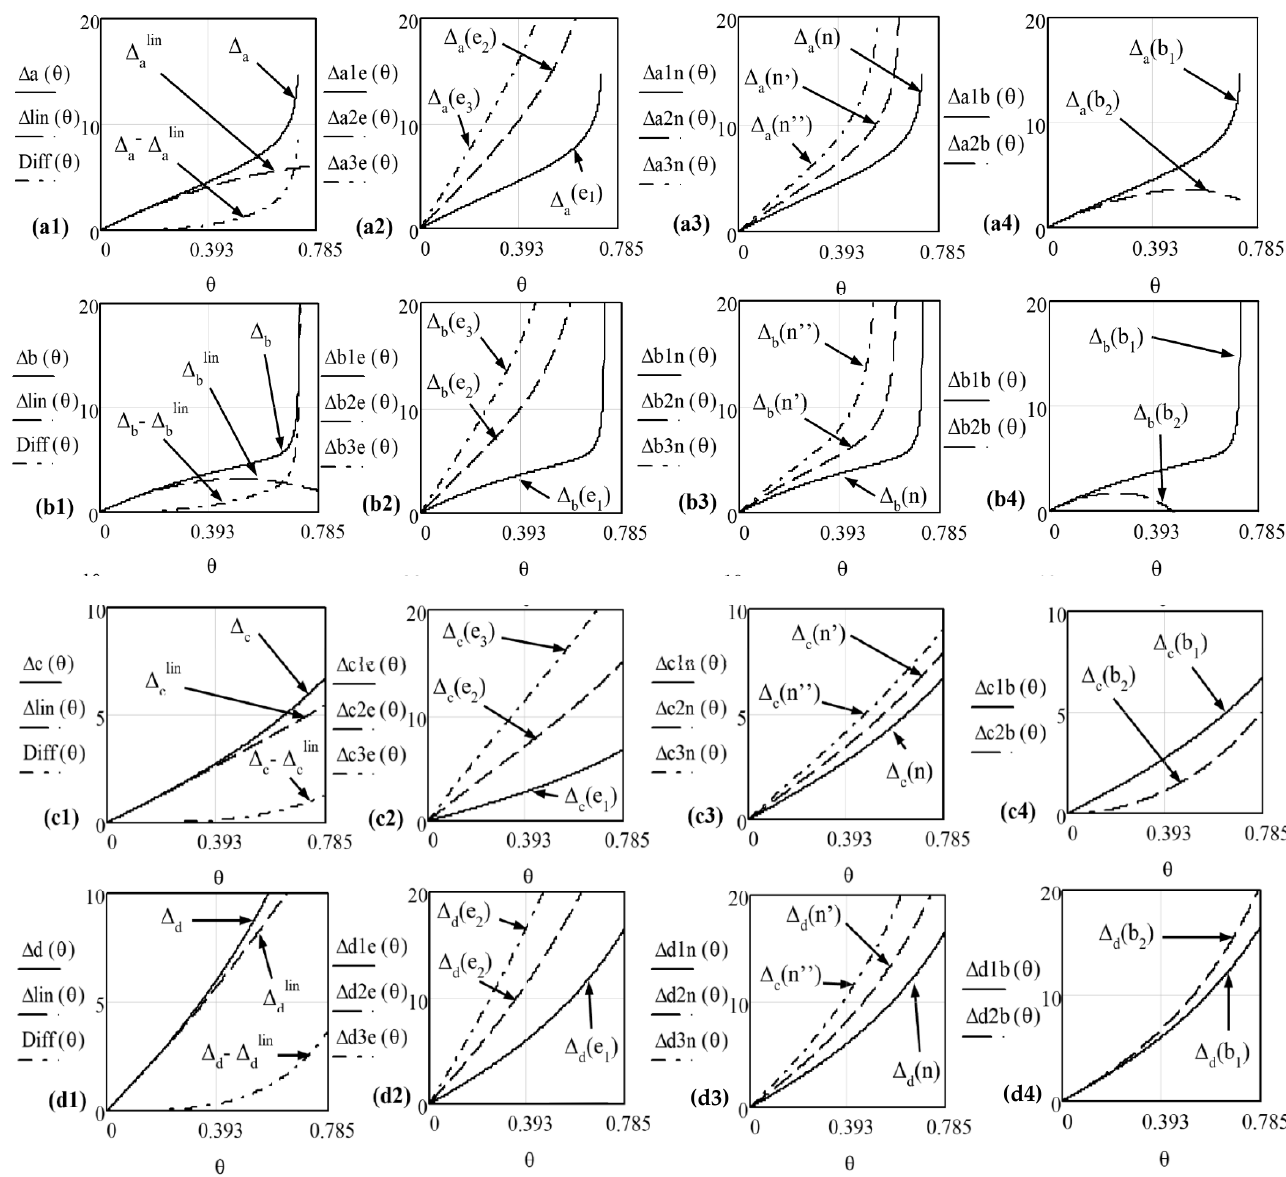
Figure 11. ( a ) Minimum linear deviations/radiuses ∆ j ( θ ) , j = a , b , c , d of the blind spot, i.e., of the central disk of the scan patterns (Figure 2(a2,b2,c2,d2)): study carried out for identical prisms (with n 1 = n 2 = n and θ 1 = θ 2 = θ , therefore for k = 1) for each of the four configurations, ( a ) Equation (15), ( b ) Equation (21), ( c ) Equation (27), ( d ) Equation (35). Characteristics of the study on columns: ( 1 ) Exact radiuses ∆ j ( θ ) , j = a , b , c , d compared with the approximate/linearized radius ∆ ( θ ) , j = a , b , c , d given by ( a ) Equation (16), ( b ) Equation (22), ( c ) Equation (28), and ( d ) Equation (36) for n = 1.517, e = 25 mm, and b = 12.7 mm; ( 2 ) Exact radiuses for three values of the distance between the prisms e 1 = 25, e 2 = 50, and e 3 = 75 mm, for n = 1.517 and b = 12.7 mm; ( 3 ) Exact radius for three values of the refractive index of the prisms n = 1.517, n’ = 1.7, and n ” = 1.9 mm, for e = 25 mm and b = 12.7 mm; ( 4 ) Exact radius for two values of the radius of the prisms, b 1 = 12.7 and b 2 = 25.4 mm, for n = 1.517 and e = 25 mm.